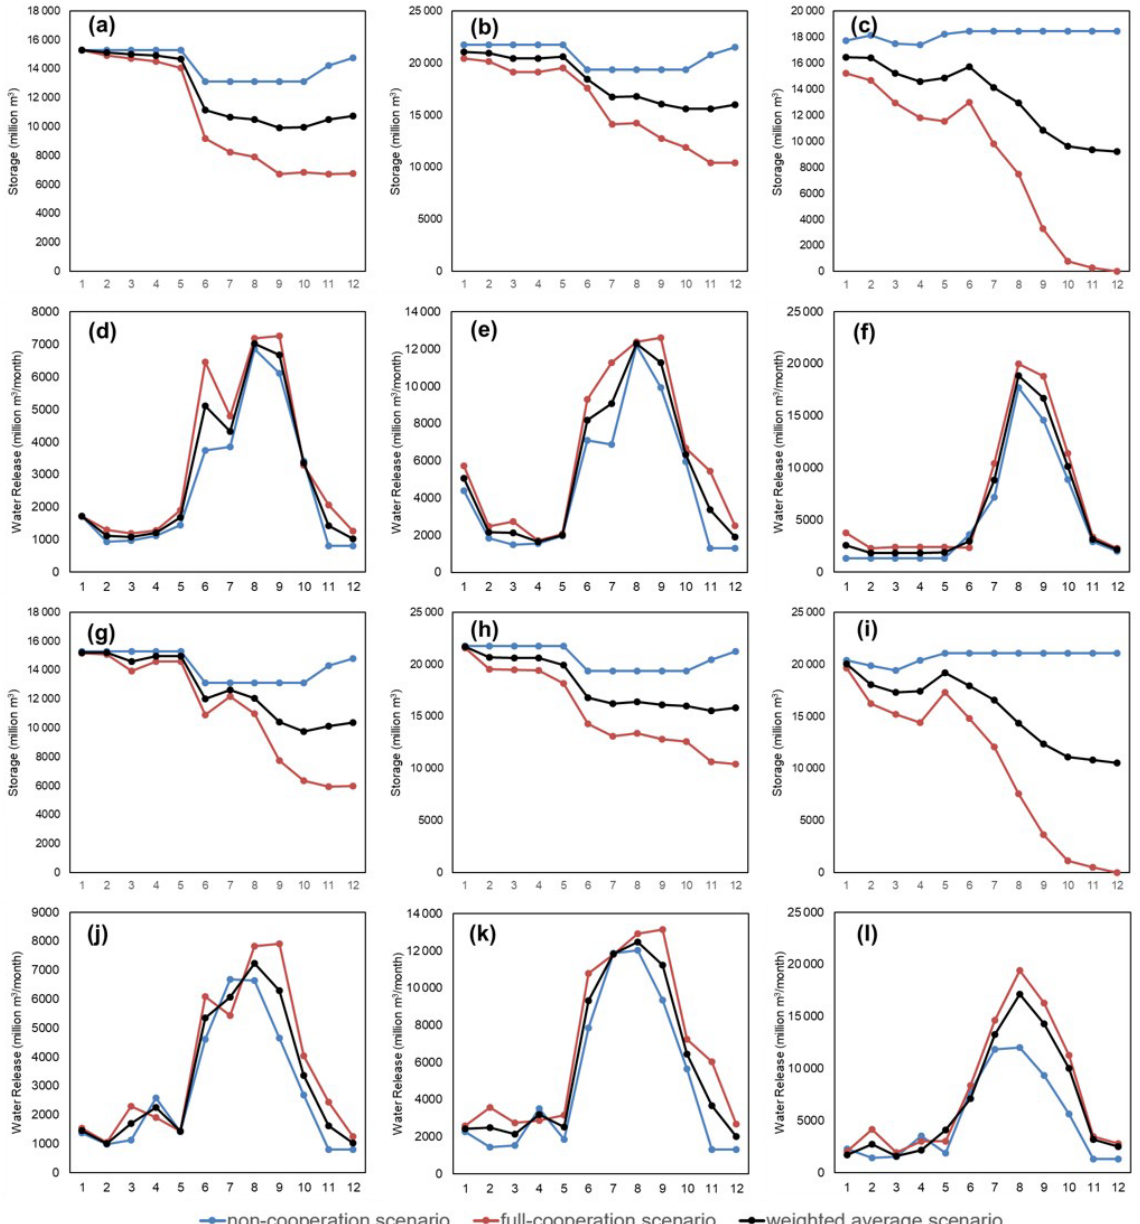
Figure 6. Reservoir storage and water release simulations of Xiaowan, Nuozhadu and Laos reservoirs in 2015 and 2017. (a) Xiaowan reservoir storage in 2015. (b) Nuozhadu reservoir storage in 2015. (c) Virtual Laos reservoir storage in 2015. (d) Water release of Xiaowan reservoir in 2015. (e) Water release of Nuozhadu reservoir in 2015. (f) Water release of the virtual Laos reservoir in 2015. (g) Xiaowan reservoir storage in 2017. (h) Nuozhadu reservoir storage in 2017. (i) Virtual Laos reservoir storage in 2017. (j) Water release of Xiaowan reservoir in 2017. (k) Water release of Nuozhadu reservoir in 2017. (l) Water release of the virtual Laos reservoir in